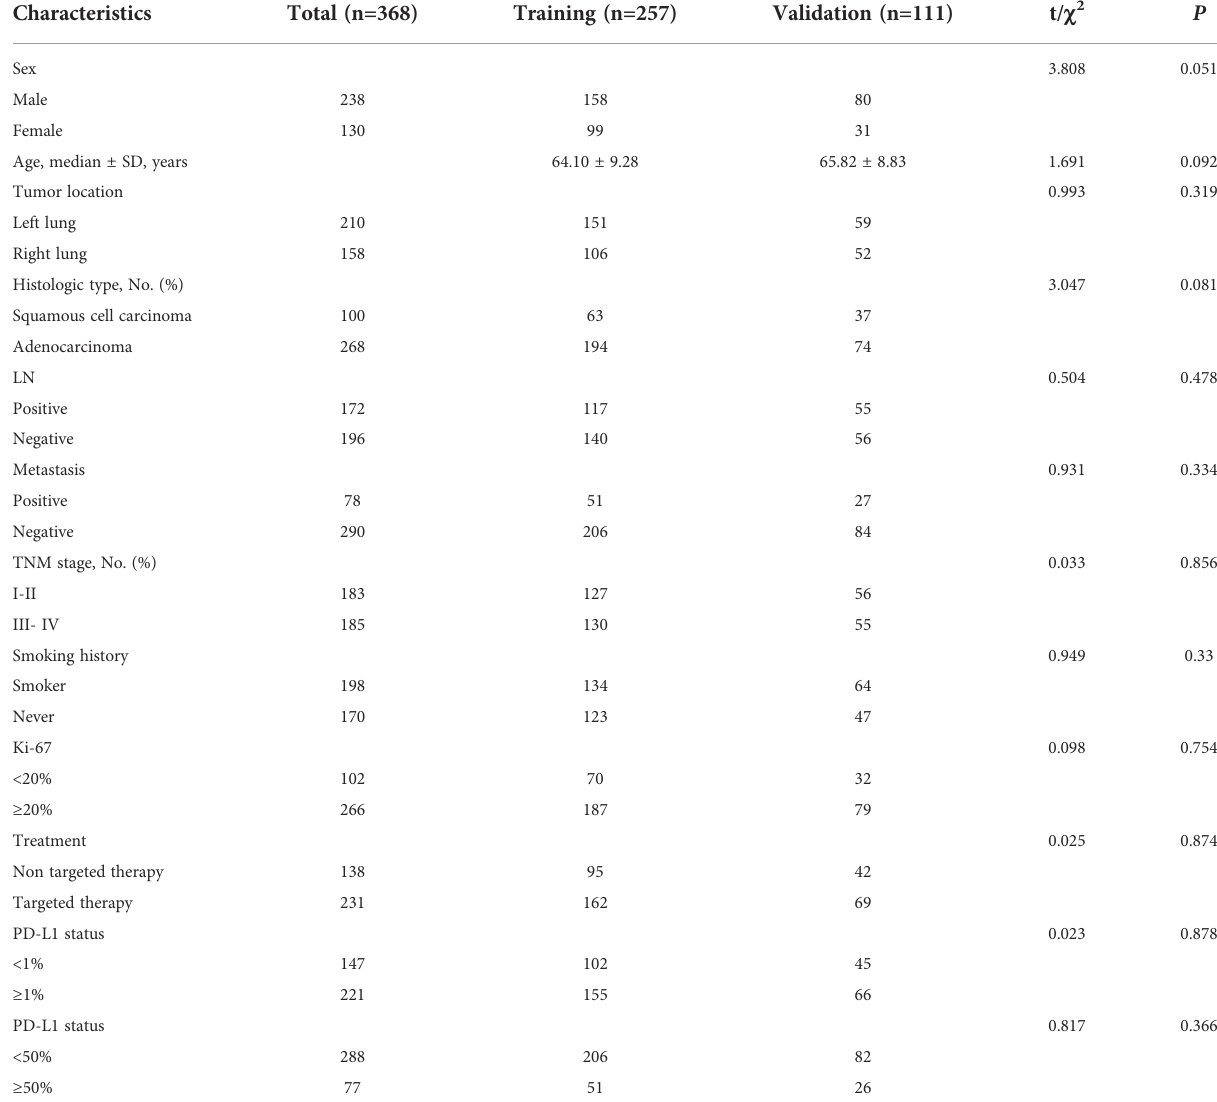
TABLE 1 Clinical characteristics of patients in the training and validation cohorts.